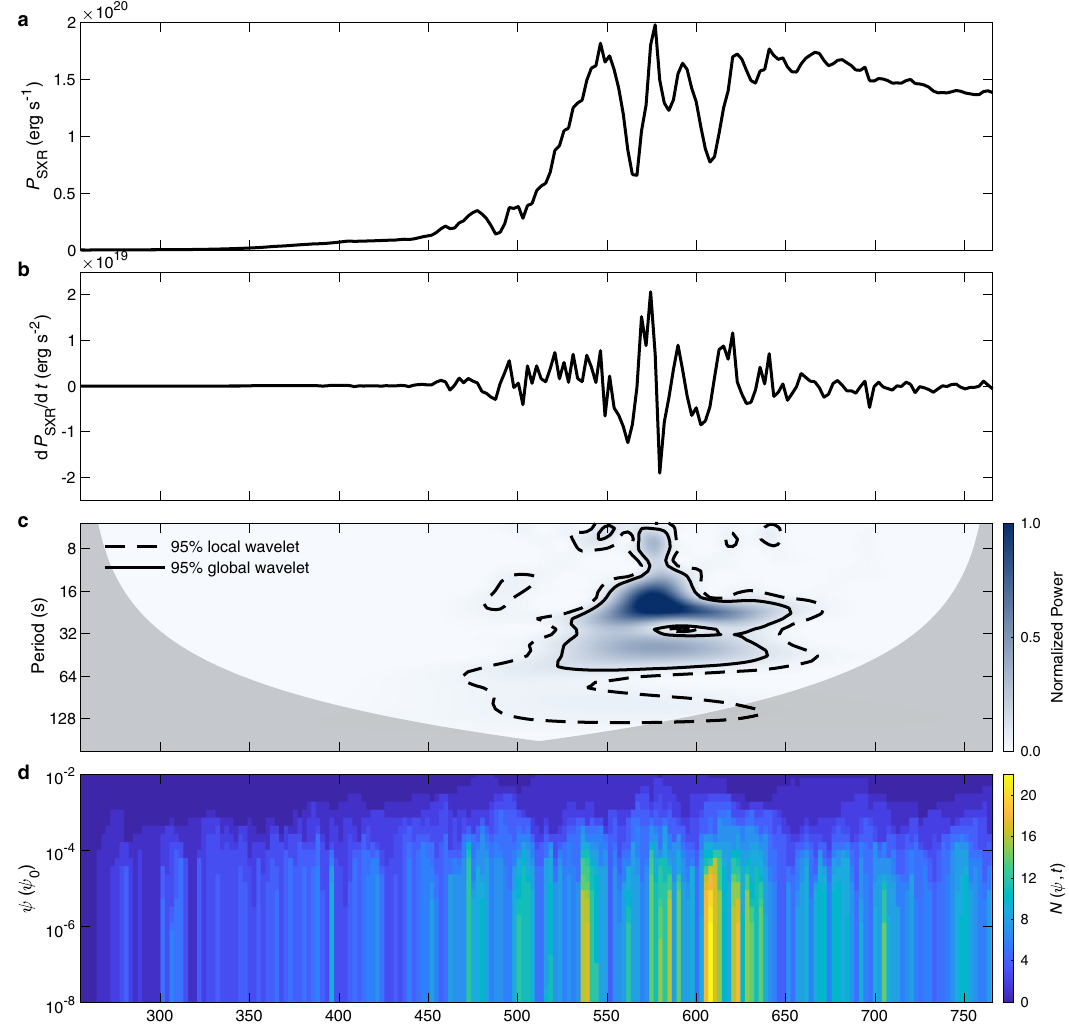
line) and local (dashed line) signi fi cance is higher than 95%. d The evolution of the number distribution function of the magneticisland fl ux, N ψ , t ð Þ , in the integration region, where ψ is the fl ux of magnetic islands and ψ 0 =10 11 Mxcm − 1 . N ψ , t ð Þ is calculated by the same method as in ref.